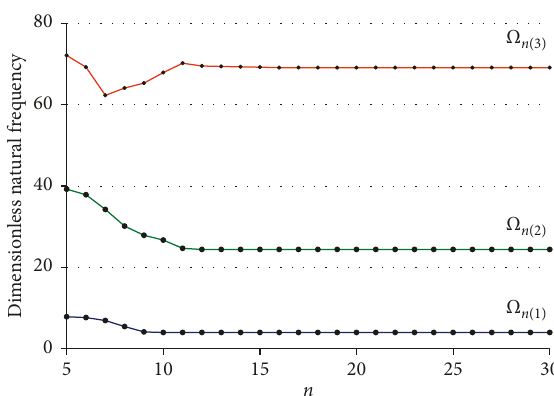
Figure 6: Convergence plots for natural frequencies when P � 0 and K